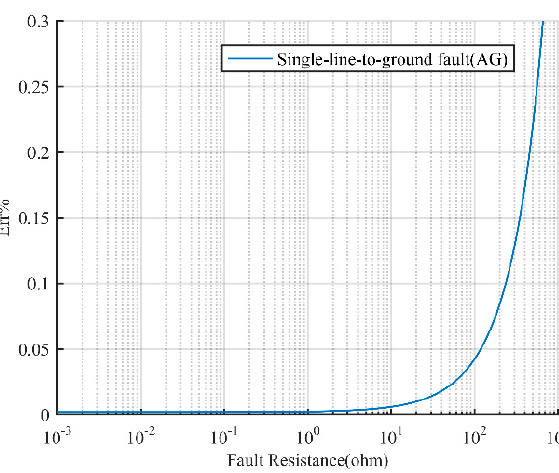
Figure 11. Influence of the fault resistance.